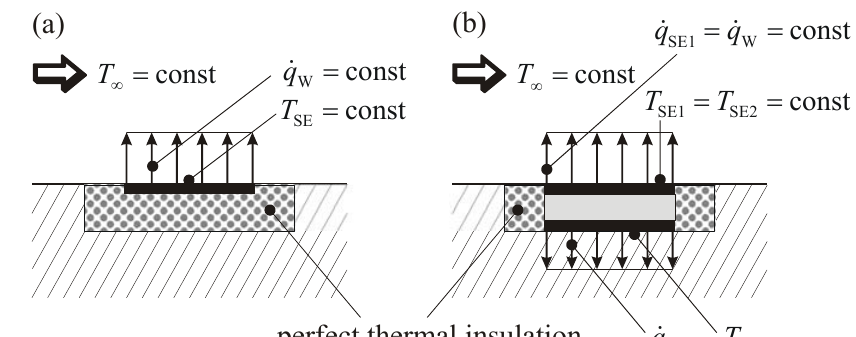
Figure 3. Idealized sensor configurations. (a) Single foil (SE) in a perfect thermal insulation. (b) Double foil (SE1, SE2) with a perfect counter heating by the sensitive element